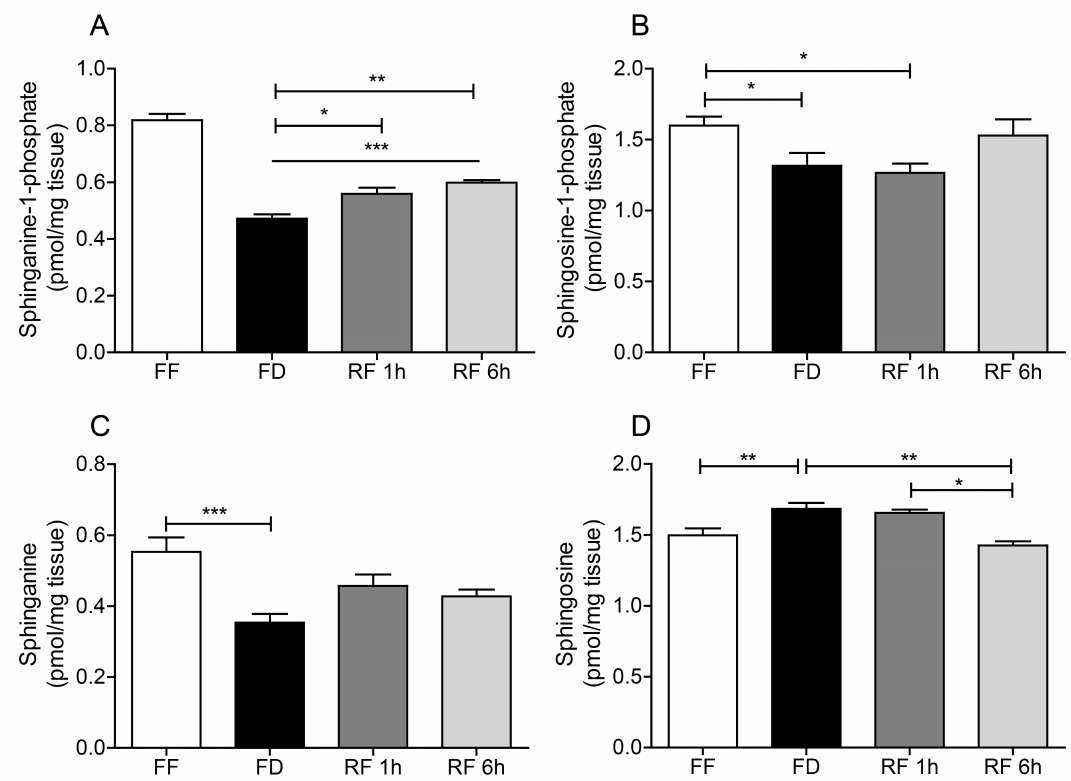
Figure 2. E ff ects of feeding status on ( A ) sphinganine-1-phosphate, ( B ) sphingosine-1-phosphate, ( C ) sphinganine and ( D ) sphingosine in mouse hypothalamus. Free feeding (FF), 12 h food deprivation (FD), 1 h refeeding after FD (RF 1h), and 6 h refeeding after FD (RF 6h). Results are expressed as mean ± SEM ( n = 5–10 / feeding condition). * p < 0.05, ** p < 0.01, *** p < 0.001; one-way ANOVA followed by Tukey’s multiple comparison